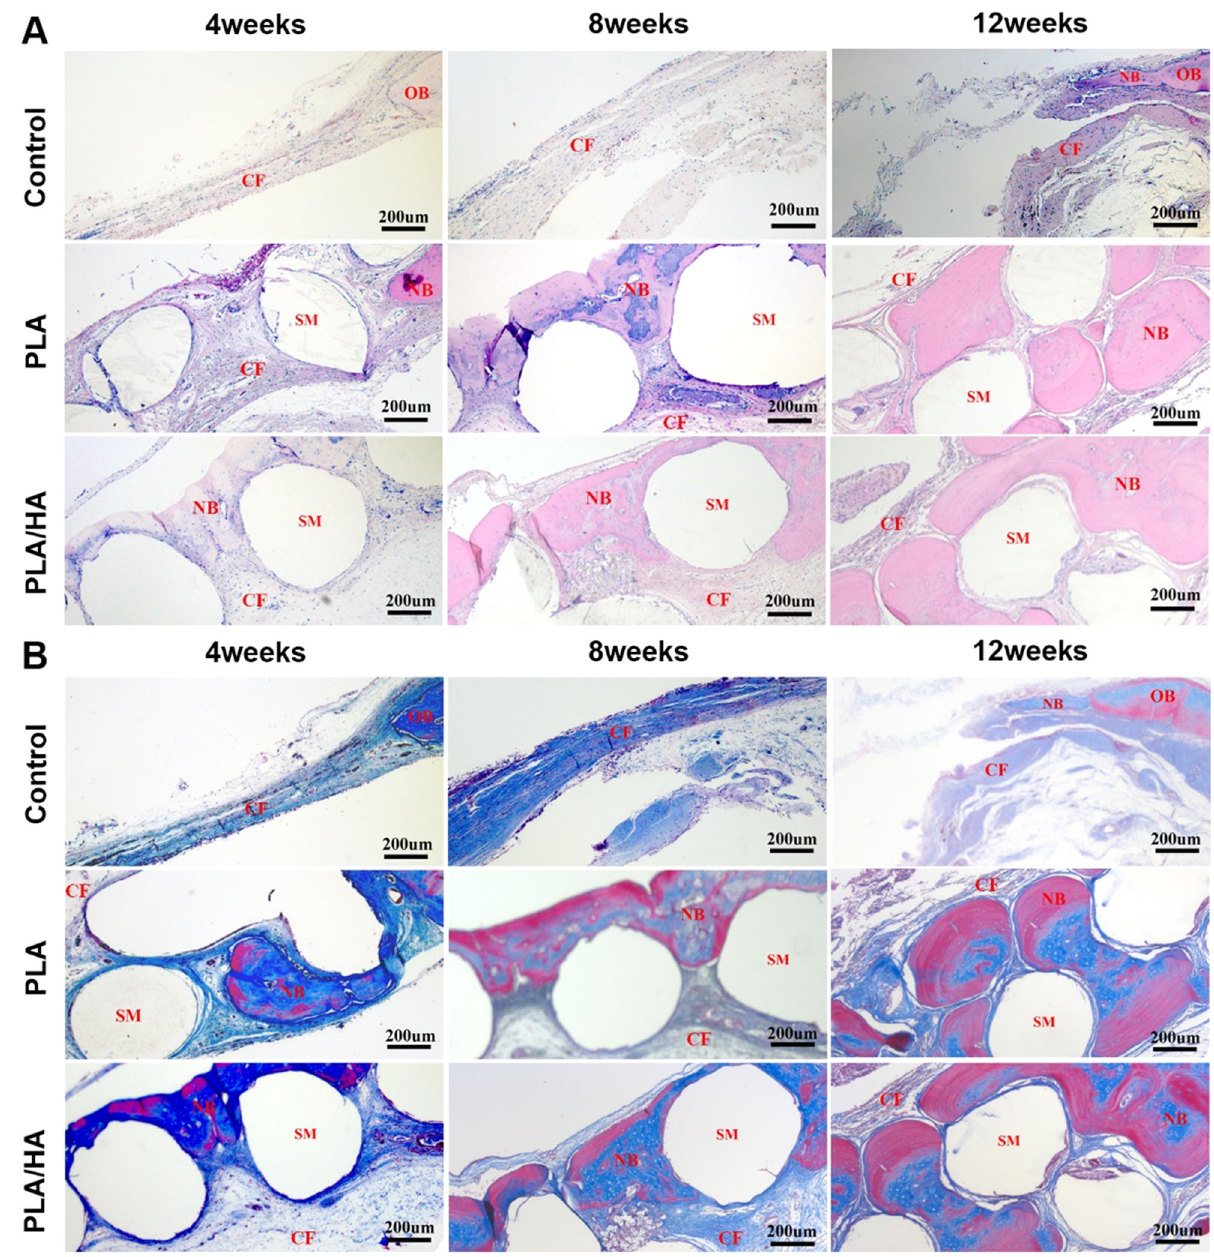
Fig. 8 Immunohistochemical staining in the different groups at 4, 8, and 12 weeks; A Hematoxylin-eosin (H&E) and B Masson ’ s trichrome staining of tissue sections in different groups at 4, 8 and, 12 weeks